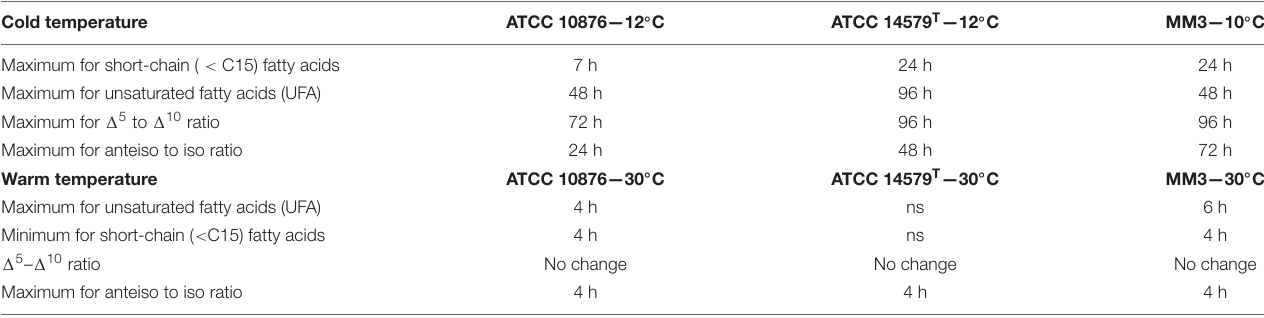
TABLE 3 | Growth time at which changes in fatty acid categories were reached for B. cereus strains ATCC 10876, ATCC 14579 T , and MM3 at cold and warm